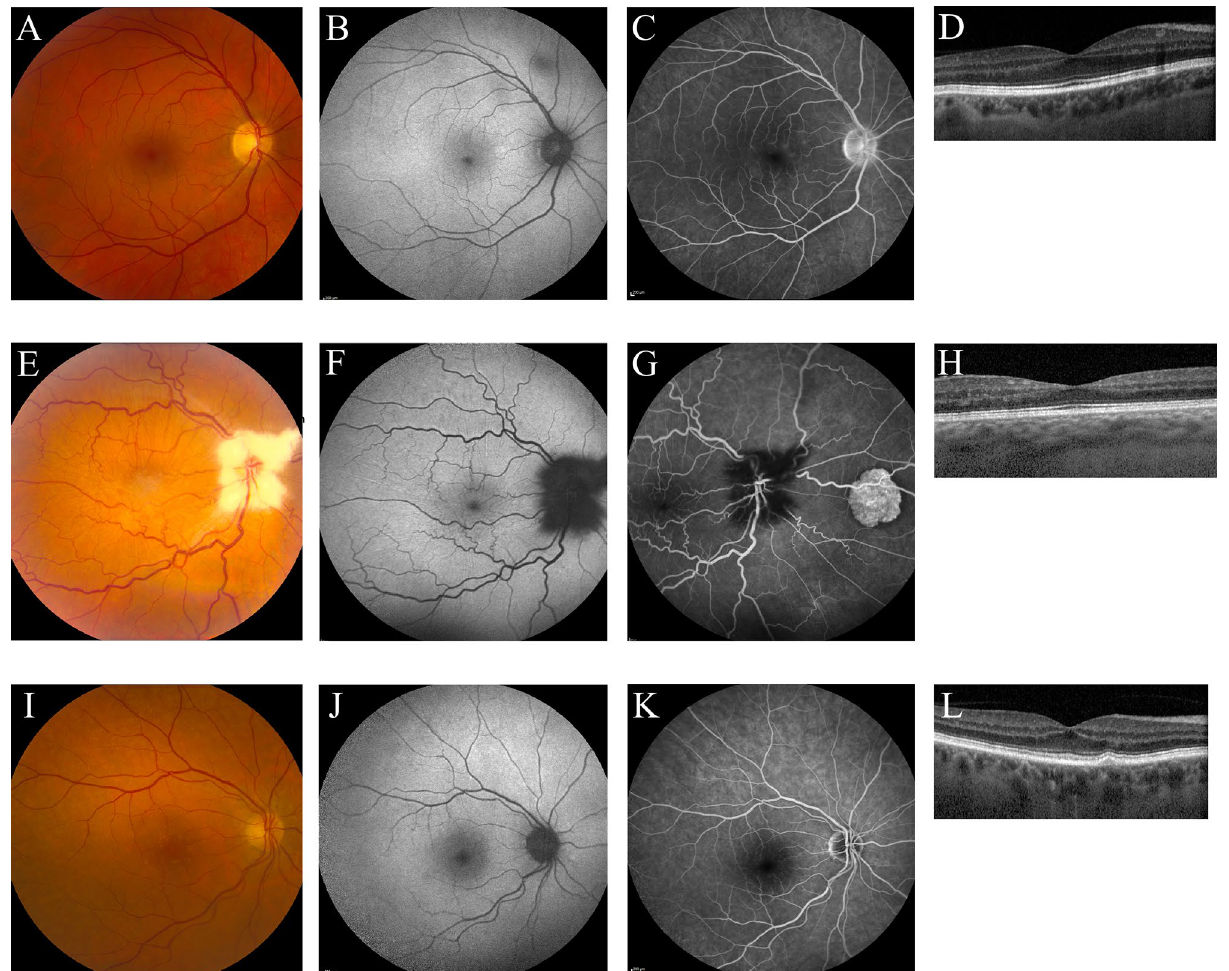
Figure 2. Multimodal imaging of ocular abnormalities not attributed to the spectrum of central serous chorioretinopathy. A 58-year-old male patient with Cushing’s syndrome due to a pituitary adenoma and a history of central retinal vein occlusion in the right eye (5 years ago) and grade 2 hypertensive retinopathy (3 years ago) showed mild parafoveal hyperfluorescent changes on fluorescein angiography ( C ). No abnormalities were observed on fundus photography ( A ), fundus autofluorescence imaging ( B ), and the foveal optical coherence tomography (OCT) scan ( D ). Furthermore, no abnormalities were found in the left eye on any of the imaging modalities (imaging not shown). The observed abnormalities in the right eye were stable after 1 year of follow-up after the first visit (imaging not shown). A 50-year-old male patient with Cushing’s syndrome due to a pituitary adenoma, who had a history of amblyopia in the right eye. Ophthalmological examination showed myelinated fibers which were present in both eyes ( E – G ). Furthermore, on fluorescein angiography ( G ) congenital hypertrophy of the retinal pigment epithelium was visible in the right eye. Due to amblyopia in the right eye, an OCT scan of sufficient quality could not be obtained. Therefore, an OCT of the left eye is shown, on which no abnormalities were observed ( H ). Multimodal imaging of the right eye a 75-year-old female with Cushing’s syndrome due to an adrenal adenoma, which showed drusen on fundus photography ( I ), with only very mild changes on fundus autofluorescence imaging ( J ), mid-phase fluorescein angiography ( K ), and the foveal OCT scan ( L ). These observations were similar in the left eye (imaging not on FA, which was considered to be characteristic of chronic arterial hypertension (Fig. 2A–D). These changes showed to be stable over time at a second visit within the current study. For 2 other patients within this group a second visit was scheduled as well, but also for these patients no changes were observed compared to the first visit (Table 2). Another patient showed myelinated nerve fibers and an epiretinal membrane in both eyes, together with congenital hypertrophy of the RPE in the right eye (Fig. 2E–H). A patient showing drusen formation in both eyes on OCT was previously diagnosed with dry age-related macular degeneration (Fig. 2I–L). Five patients within this group preferred not to receive follow-up for this study.